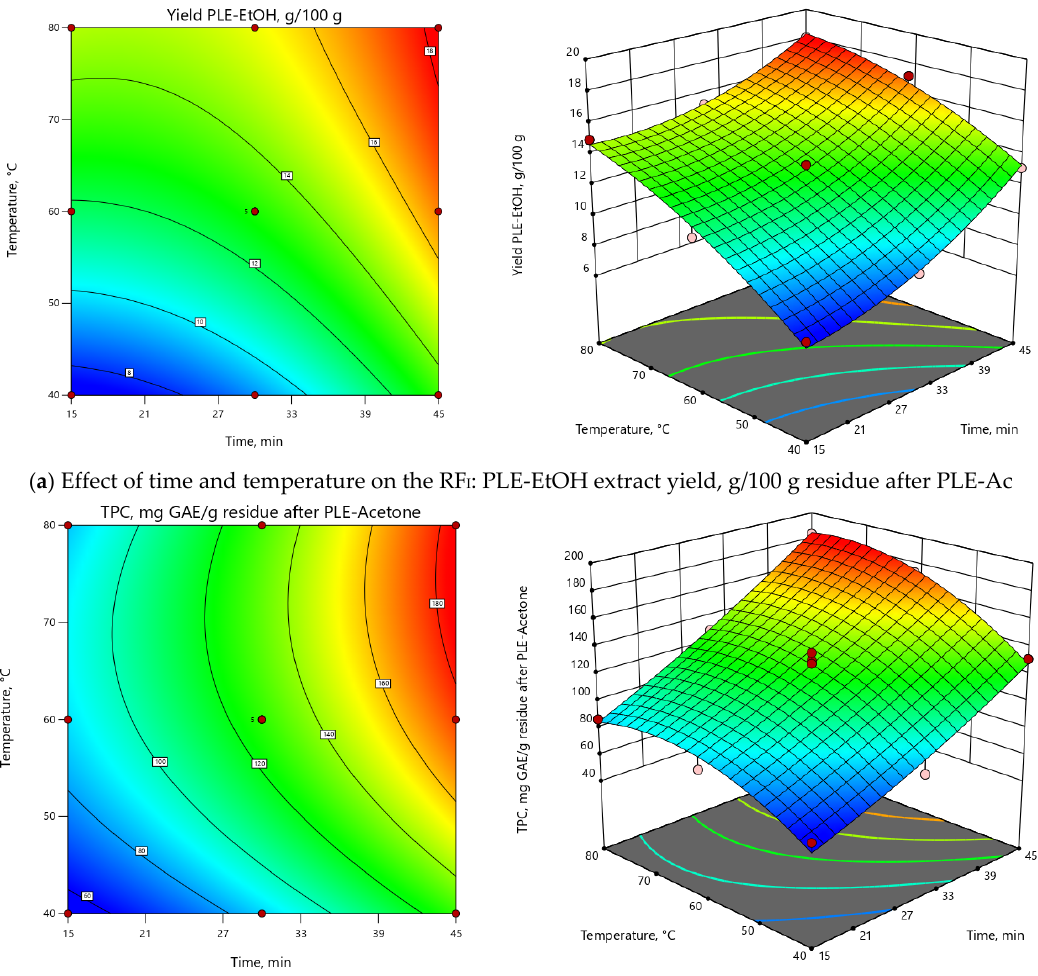
Figure 3. Response surface 3D and 2D plots showing the effects of independent variables on the selected response factors: ( a ) D. fruticosa leaves PLE-EtOH extract yield (g / 100 g residue after PLE-Ac); ( b ) total phenolic content (TPC, mg GAE / g residue after PLE-Ac).